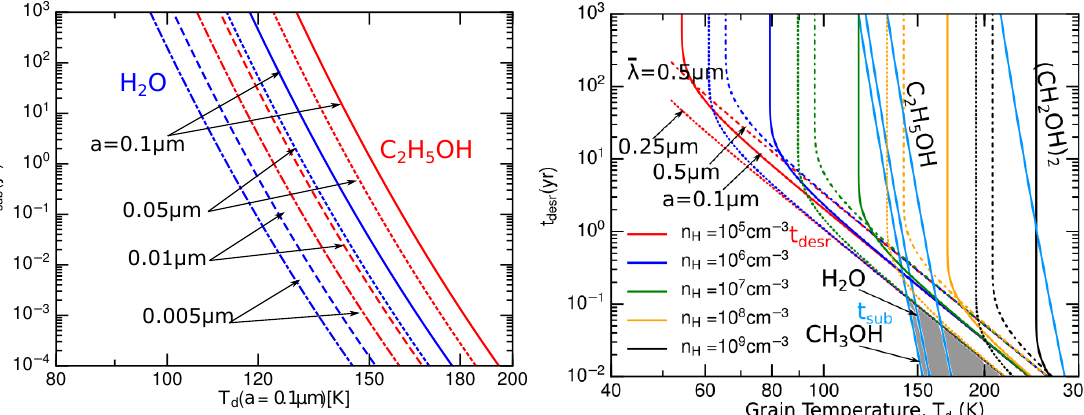
Figure 8. Left panel: Decrease of sublimation time with decreasing the grain size. Right panel: Comparison of rotational desorption time and thermal sublimation time of various